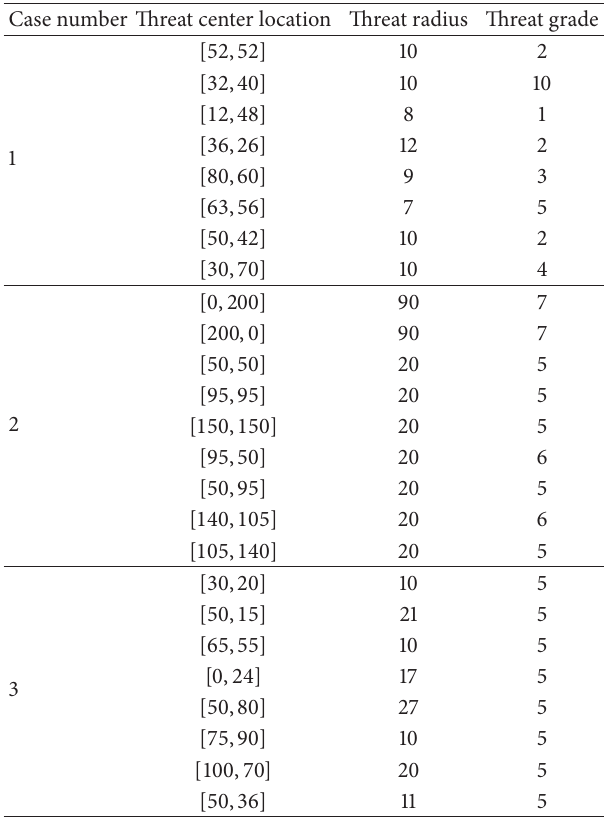
Table 1: Information of threat installations in combat